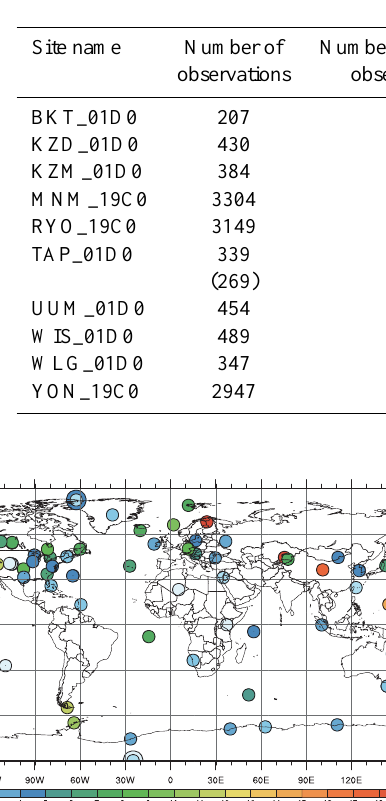
Table 3. Information on the observation sites located in Asia, including the number of observations, number of rejected observations, MDM values, innovation χ 2 statistics, and the average bias of the model CO 2 concentrations calculated by optimized fluxes. For the TAP_01D0 site, the numbers in parentheses are values used in previous studies, and the numbers without parentheses are the modified values based on the innovation χ 2 statistics in this study.